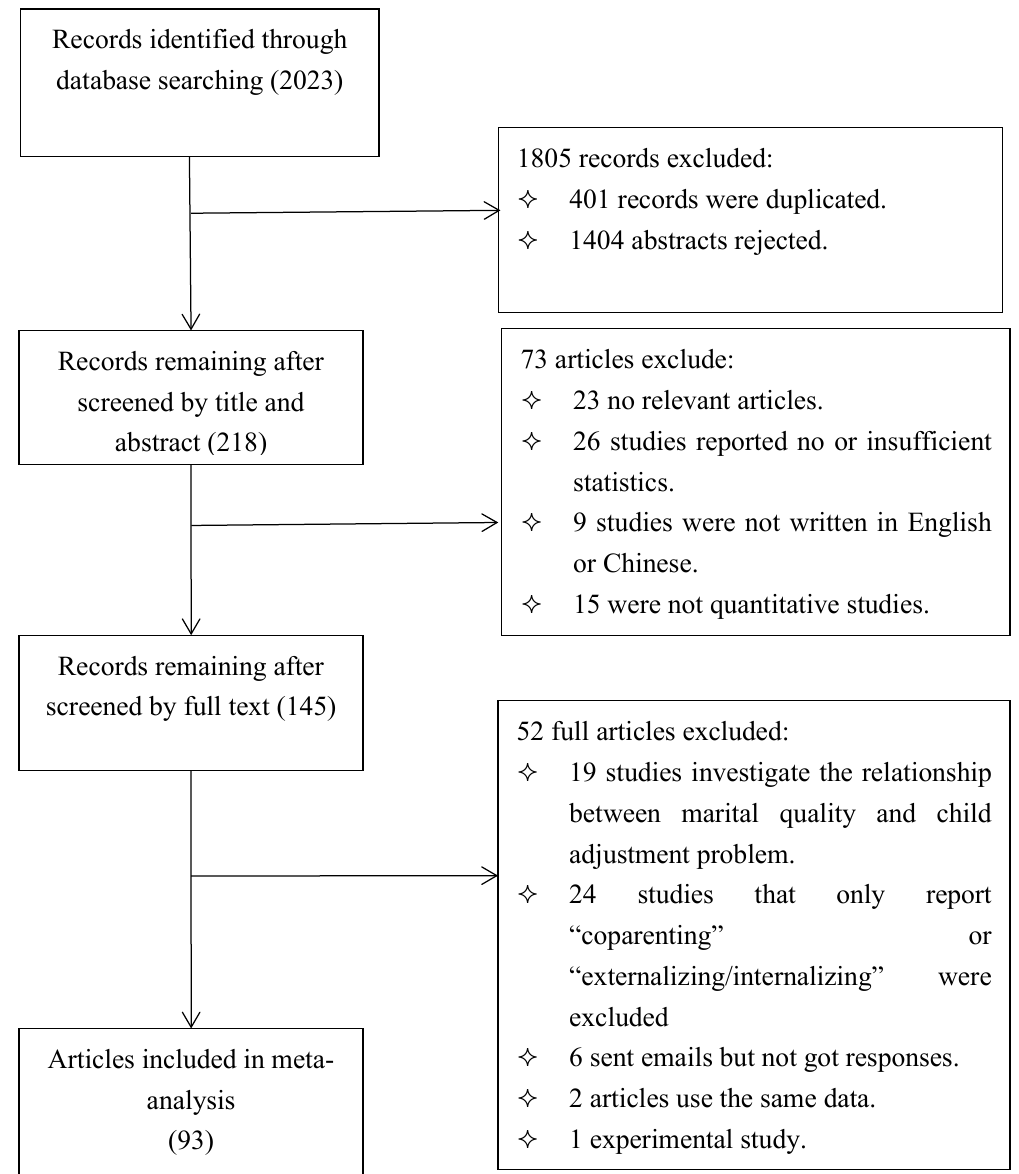
Figure 1. The PRISMA flowchart for the studies included in systematic review and meta -analysis.